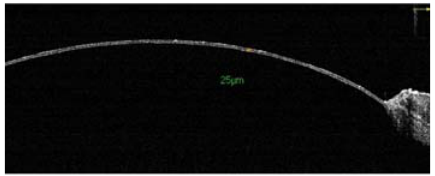
Figure 4: An intraoperative AS-OCT image taken during deep anterior lamellar keratoplasty (DALK) that confirms an optimal descemetic or predescemetic dissection.